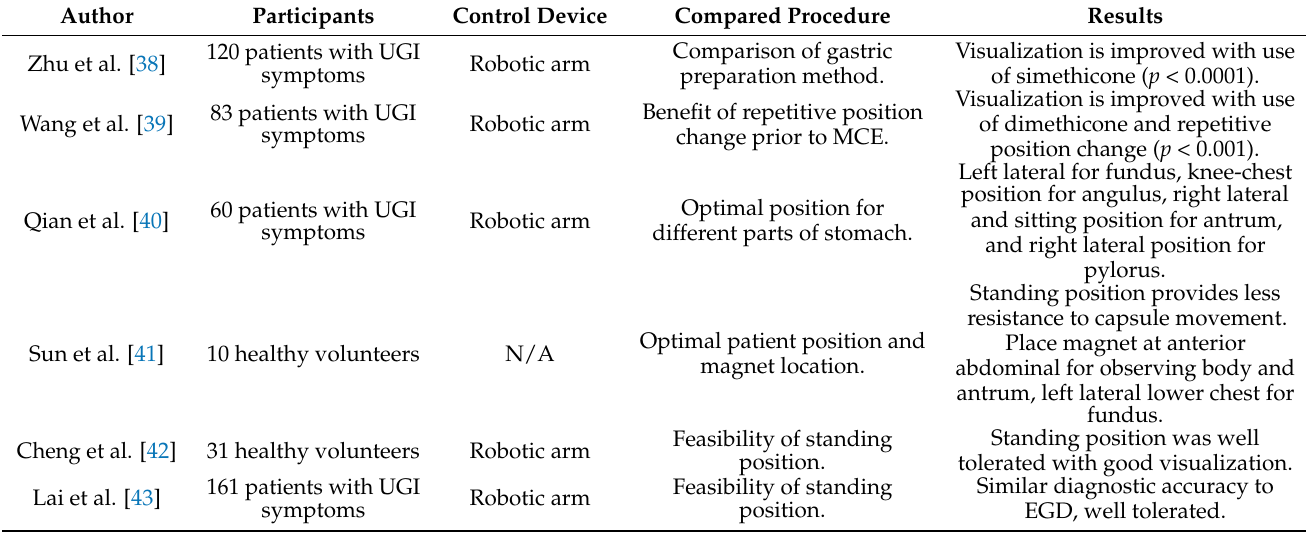
Table 5. Clinical studies on protocols of magnetically controlled capsule